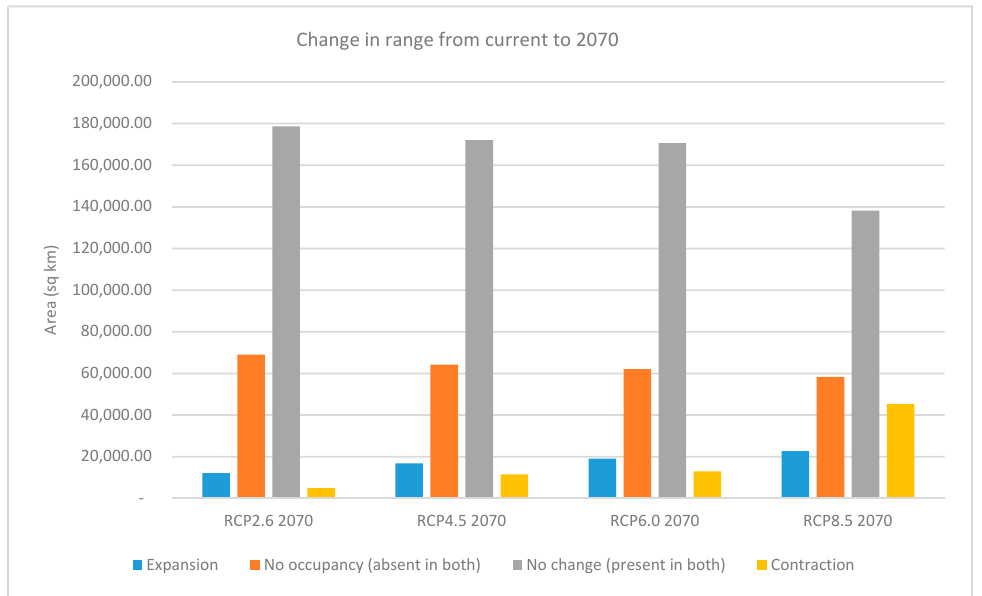
Figure 7. Prediction of range expansion and contraction for the Representative Concentration Pathways (RCPs) in 2070.